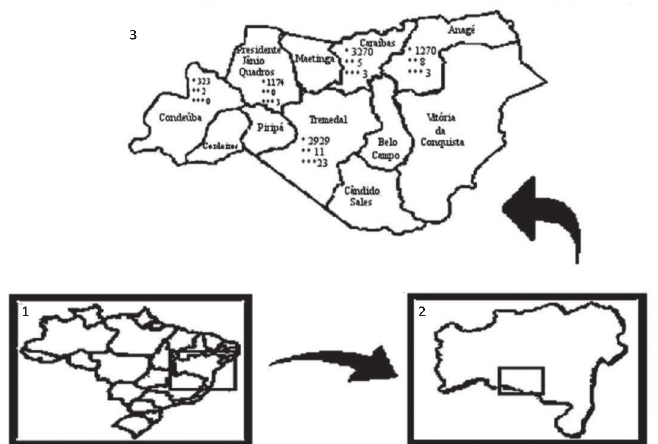
Figure 1 - Geographical distribution map of triatomines in the southwest region of Bahia. 1 – Brazil; 2 – Bahia; 3 – Southwest of Bahia. * - Total number of triatomines; ** - Number of infected triatomines by flagellate protozoa similar to T. cruzi. *** - Number of patients with Chagas disease reported by SINAN system, period 2008 to